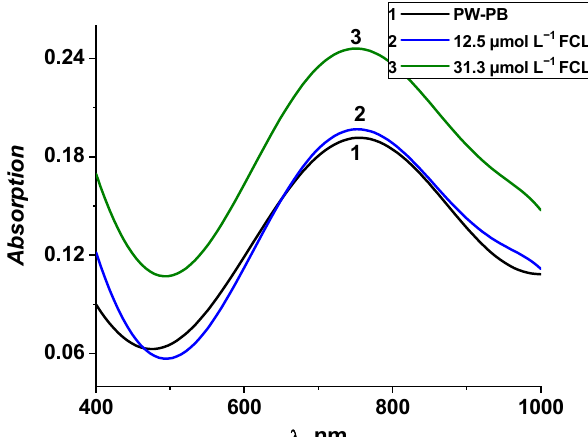
Figure 8. Optical absorption spectra of the glass|FTO|PW-PB electrode registered in PBS without FCL (curve 1); in PBS containing 12.5 µ mol L − 1 of FCL (curve 2); in PBS containing 31.3 µ mol L − 1 of FCL (curve 3). Absorption spectra of the glass|FTO|PW-PB electrode in FCL-containing PBS (curves 2 and 3) were recorded 10 min after the addition of FLC into PBS.